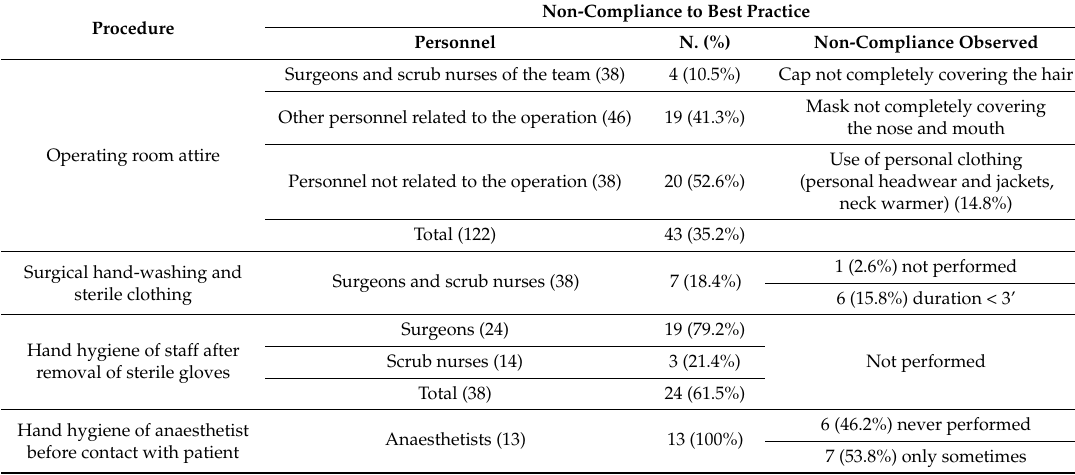
Table 5. Compliance to best practices. Observations regarding